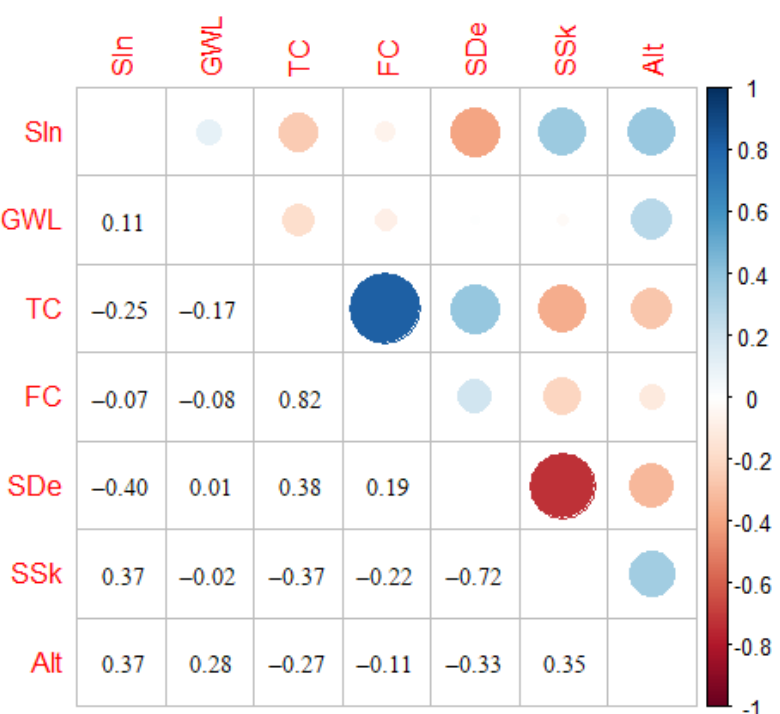
Figure 6. Matrix of Spearman‘s rank correlation